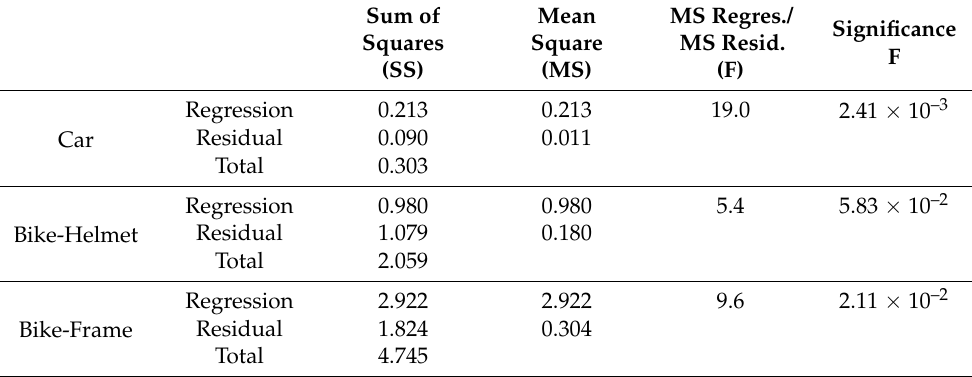
Table 3. Statistical parameters used in evaluating the performance for predicting the IRI- a wz